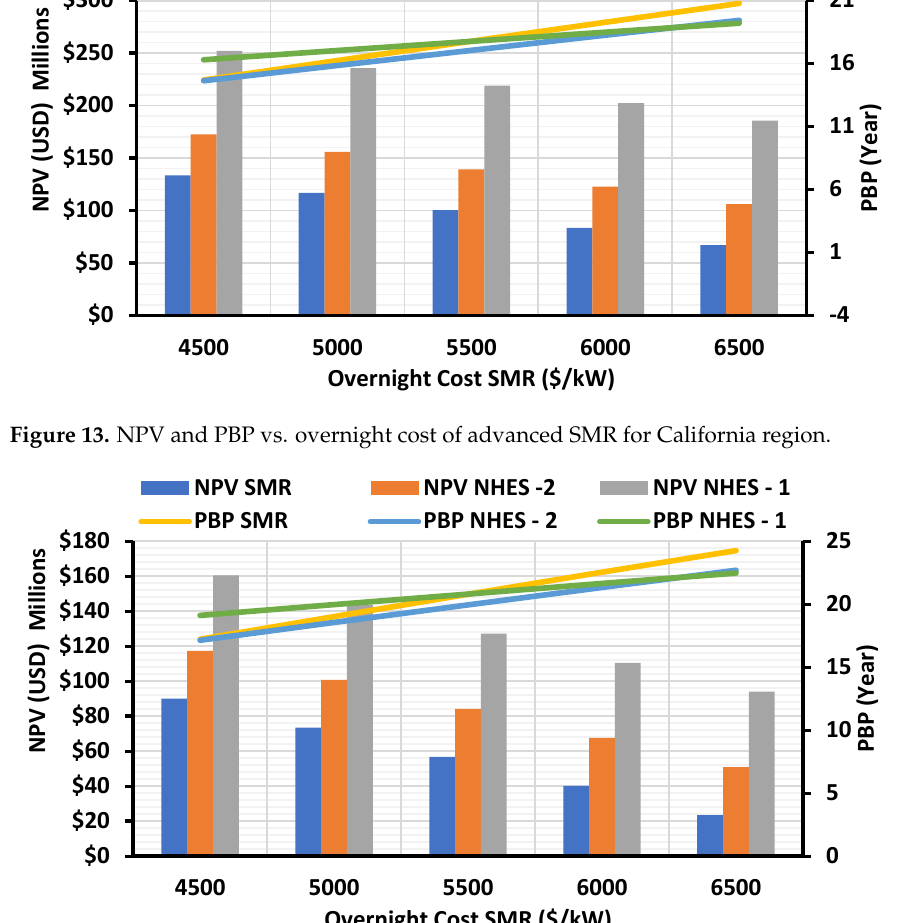
Figure 14. NPV and PBP vs. overnight cost of advanced SMR for Midwest region.